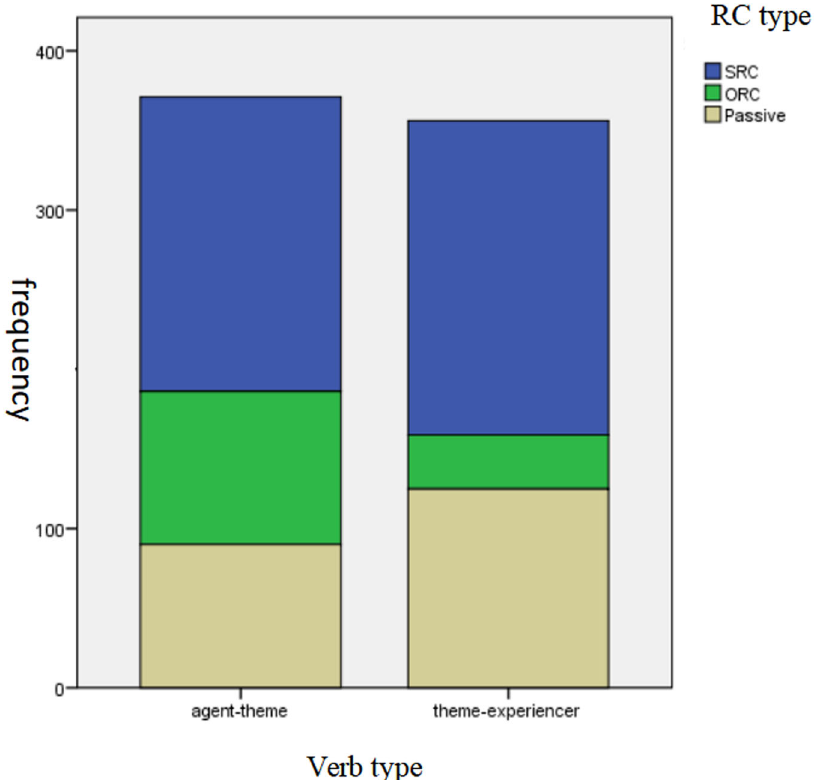
Fig. 1 Stacked area chart for SRC, ORC, and PRC containing different verb types. This fi gure shows the results of the production for the incomplete sentences containing agent-theme verbs and theme-experiencer